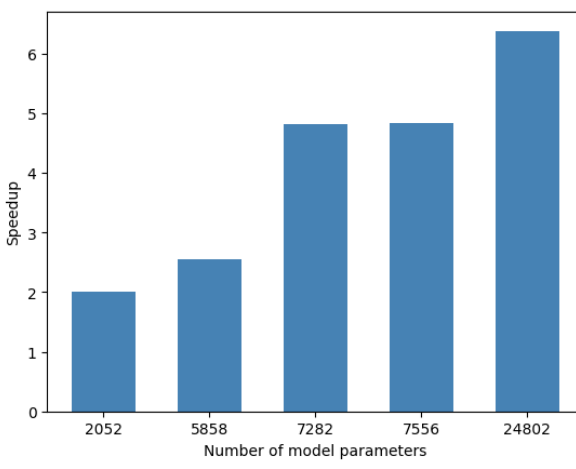
Figure 13. Relationship between the number of model parameters and speed increase factor after deployment on the